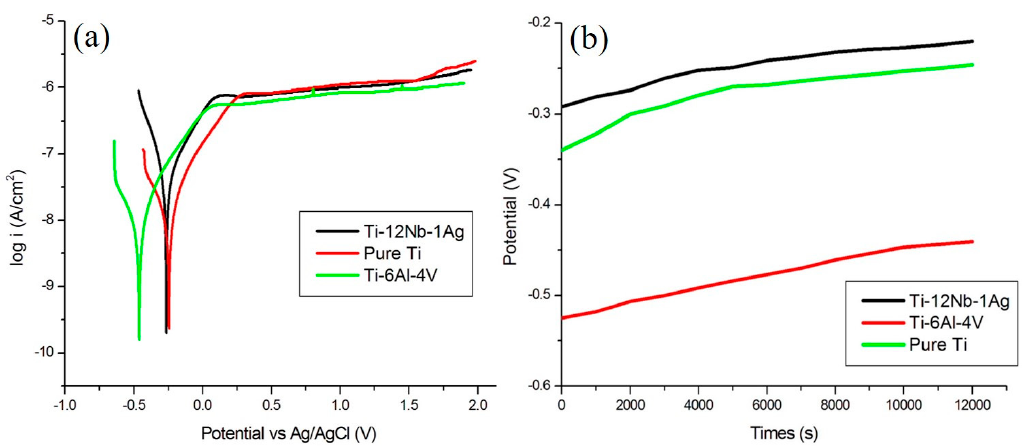
Figure 3. Electrochemical test results of Ti–12Nb–1Ag, G2 pure Ti, and Ti–6Al–4V using: ( a ) Tafel curves and ( b ) Open-circuit potential curves.